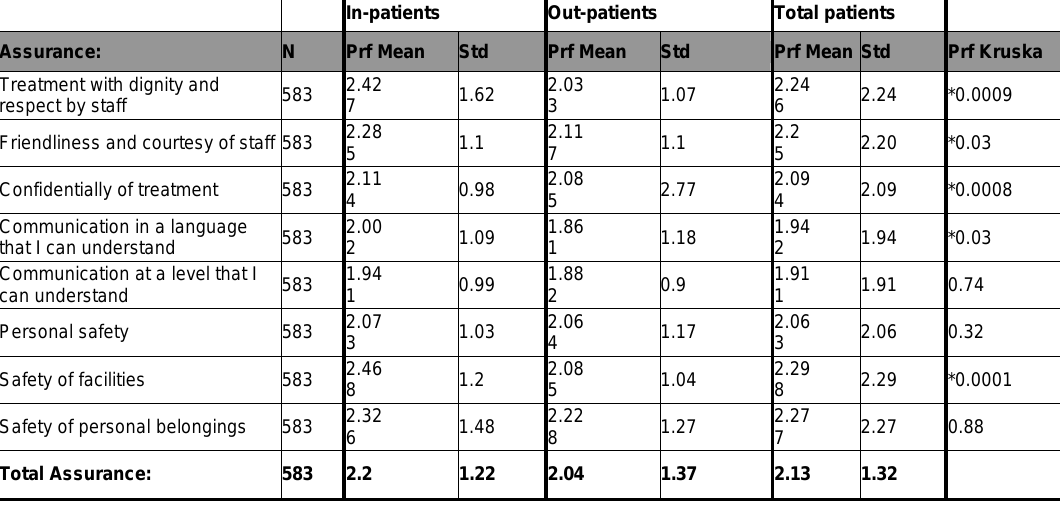
Table 4: Test for significant differences with regards to perceived performance on assurance constructs In-patients Out-patients Total